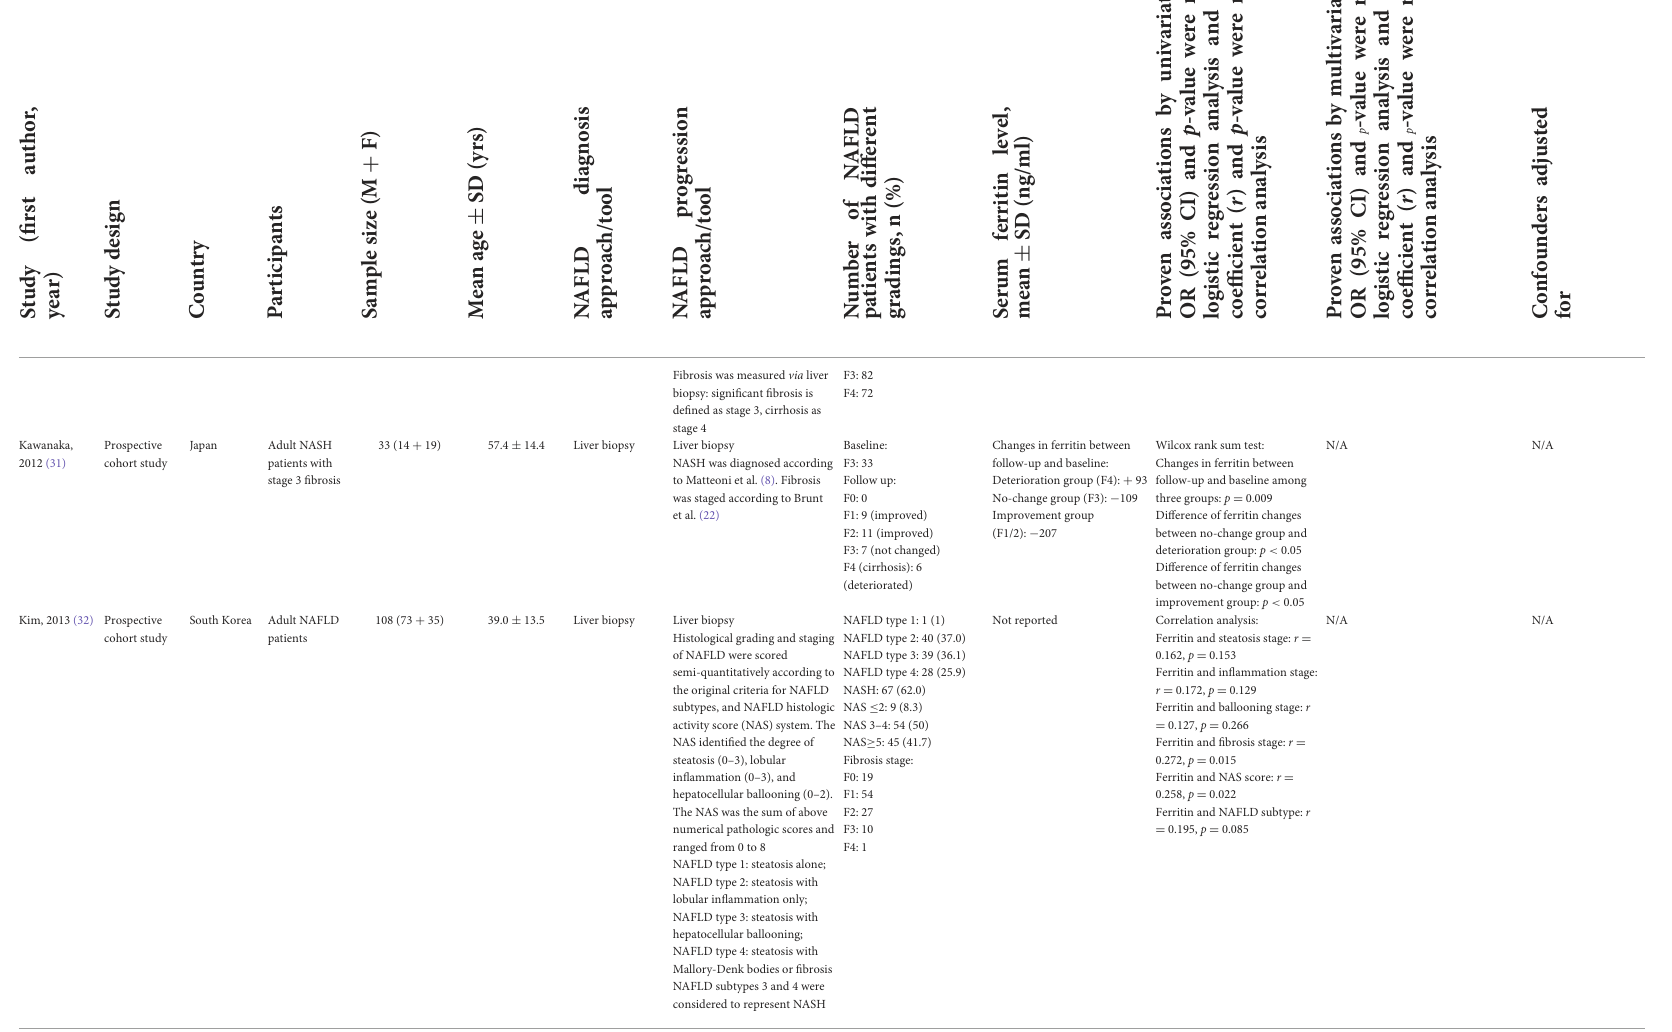
Ferritinandsteatosisstage: r = 0.162, p = 0.153 Ferritinandinflammationstage: r = 0.172, p = 0.129 Ferritinandballooningstage: r = 0.127, p = 0.266 Ferritinandfibrosisstage: r = 0.272, p = 0.015 FerritinandNASscore: r = 0.258, p = 0.022 FerritinandNAFLDsubtype: r = 0.195, p = 0.085